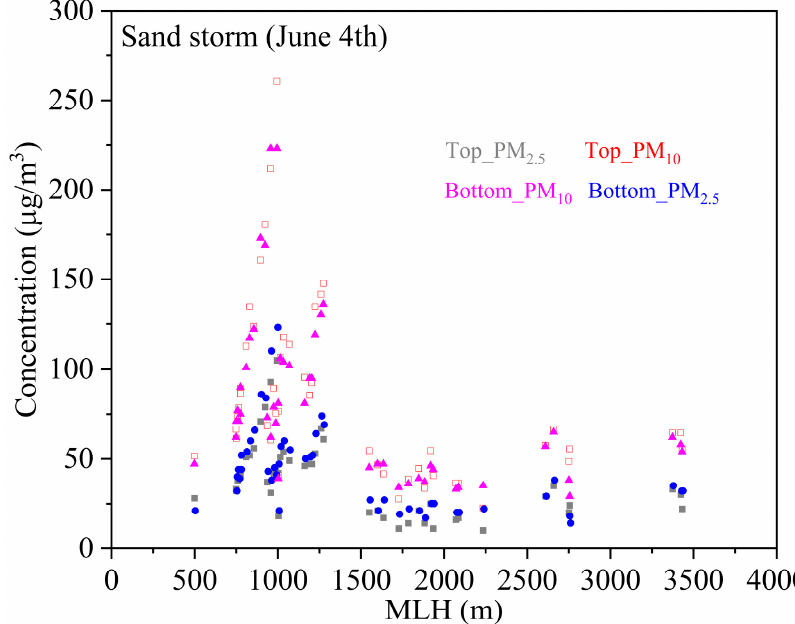
Figure 9. Relationships between dust concentrations and MLH in the TD.